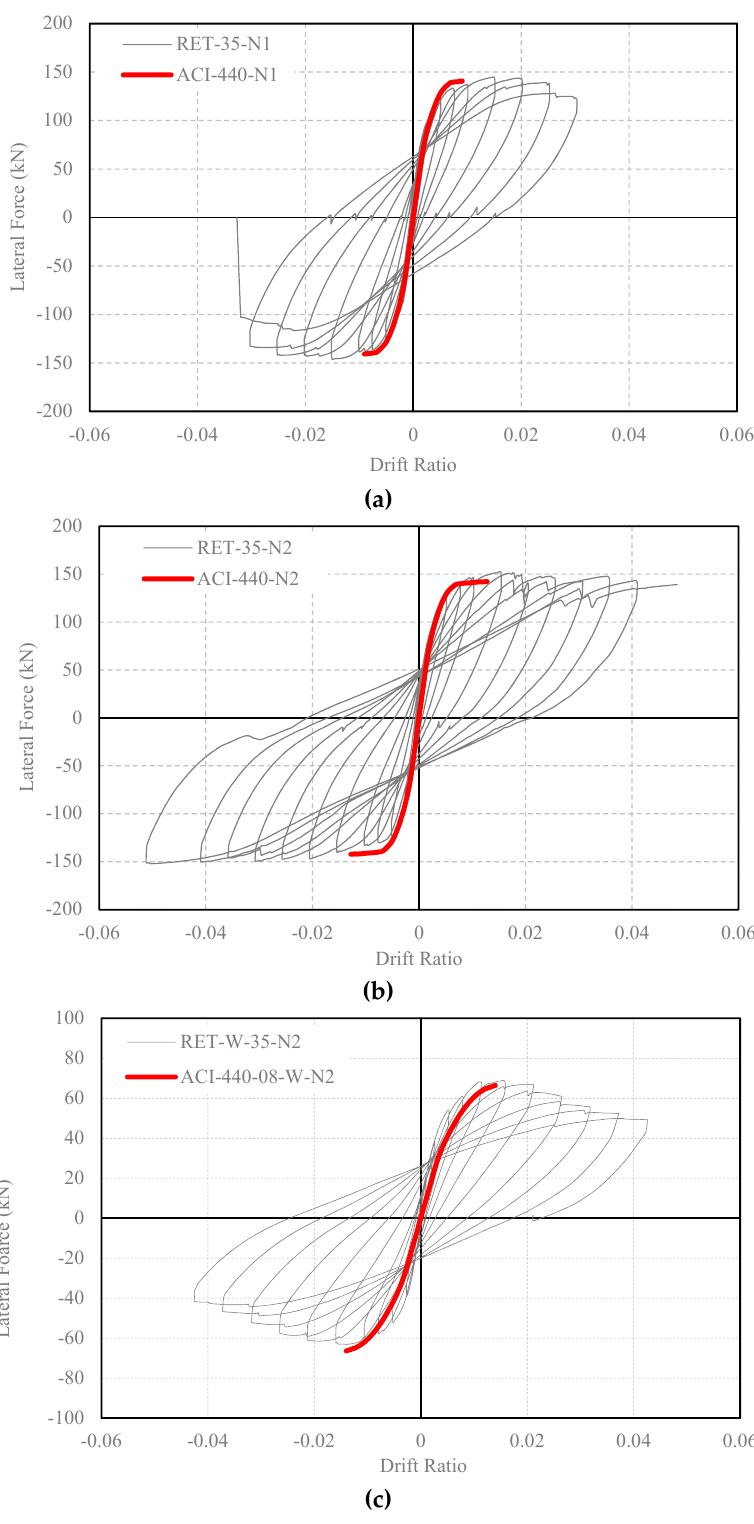
Figure 13. Comparison of experimental and analytical lateral load-drift relationships (confined concrete strength and strain capacity are obtained by using ACI 440.2R [48] equations): ( a ) RET-35-N1, ( b ) RET-35-N2 and ( c ) RET-W-35-N2.